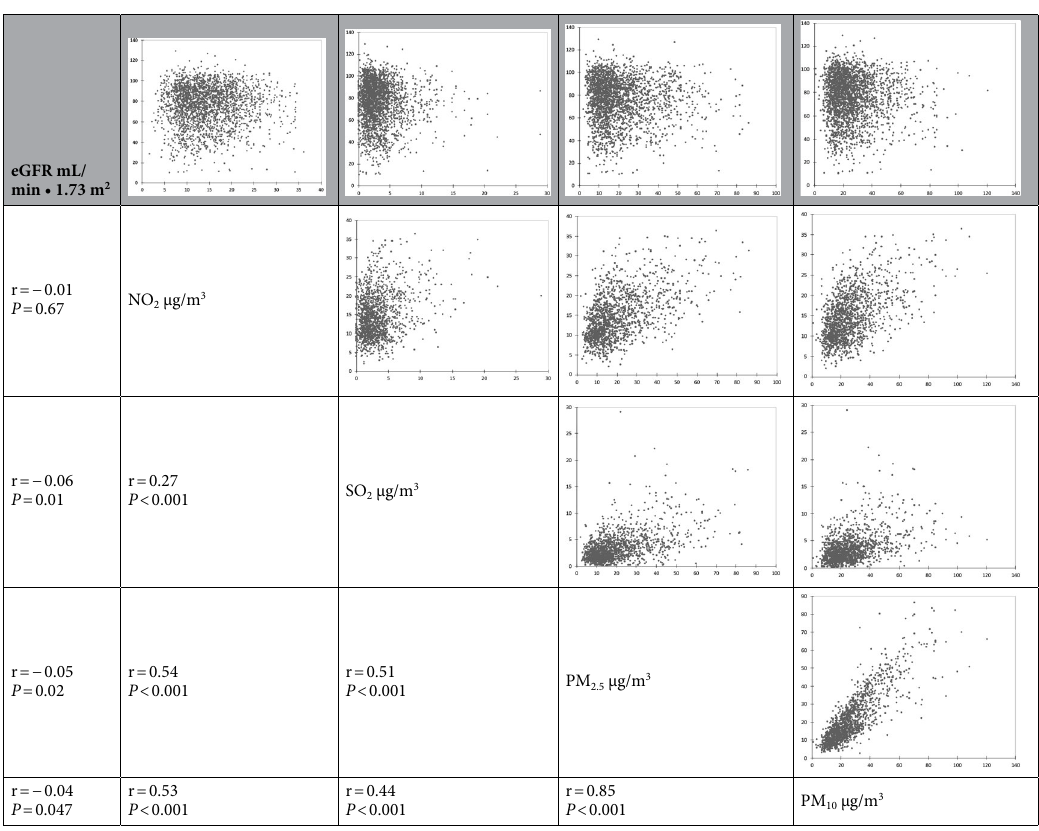
Table 4. Pearson’s correlations between eGFR at admission and air pollution concentration at LAG 1. Abbreviations : eGFR, estimated glomerular filtration rate; NO 2 , nitrogen dioxide; PM 2.5 , particulate matter with a diameter of 2.5 μm or less; PM 10 , particulate matter with a diameter of 10 μm or less; SO 2 , sulfur dioxide.